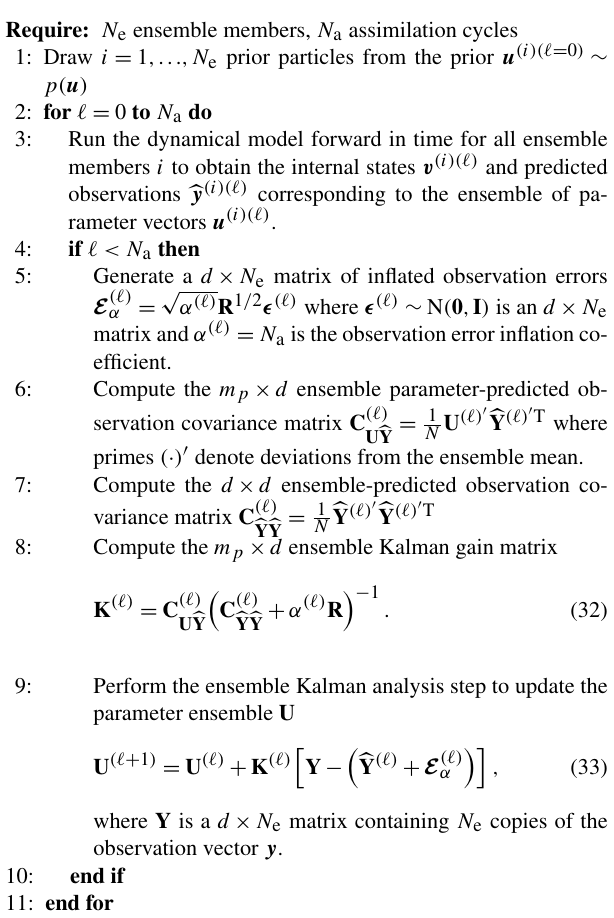
Algorithm 3 Ensemble Kalman analysis with multiple data assimilation.